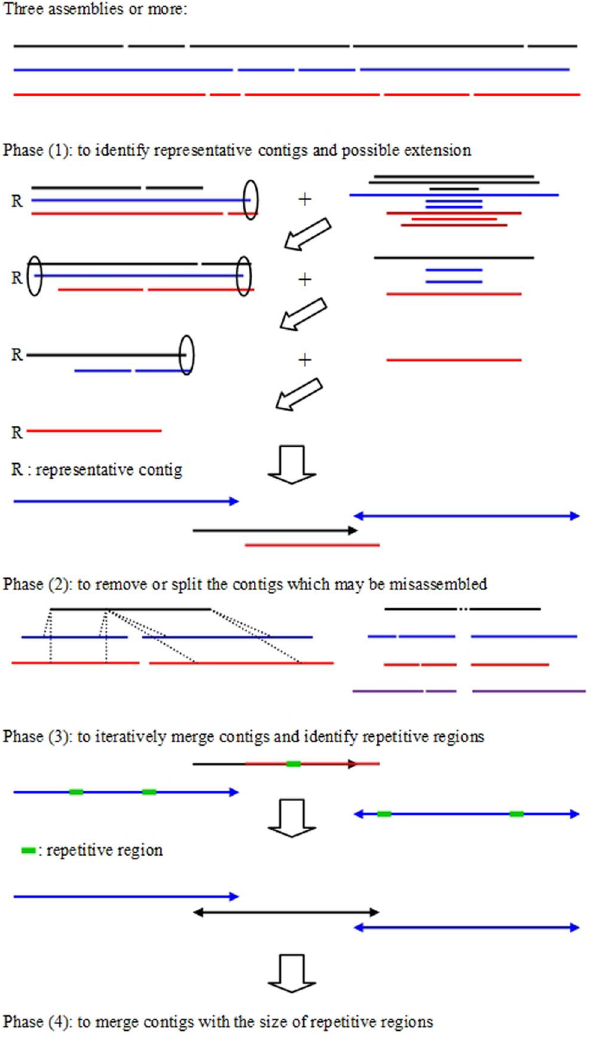
Figure 1. A schematic overview of CISA. Phase (1): employing the largest contig as a representative contig and identifying the contigs which were aligned to the ends of the representative contig with more than 80% alignment to perform possible extension (hollow ellipses and solid arrows represent before and after extension, respectively). Phase (2): removing and splitting misassembled contigs. Two misassembled contigs are shown in black. The left element represents a misjoined error because it was assembled in two different contigs in two individual assemblies (blue and red); the right element represents an insertion error (dot), which was never seen in other assemblies. Phase (3): iteratively merging contigs with a proper end-to-end overlap and estimating the size of repetitive regions. Phase (4): merging two contigs with a small overlap greater than the maximum size of repetitive